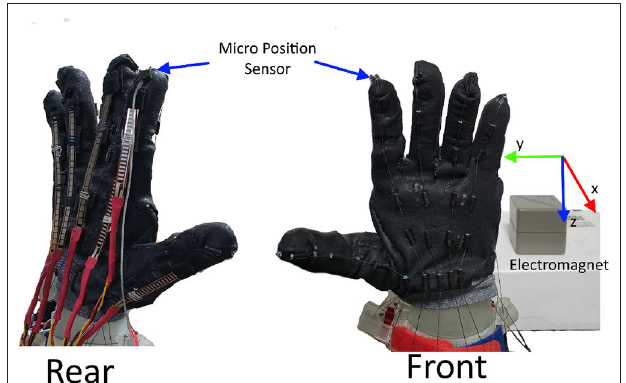
FIGURE 10 | Fingertip motion measurement setup. An high-resolution position sensor is attached to the fingertip. The position was recorded as a relative distance from the AC electromagnet located behind the robotic hand.